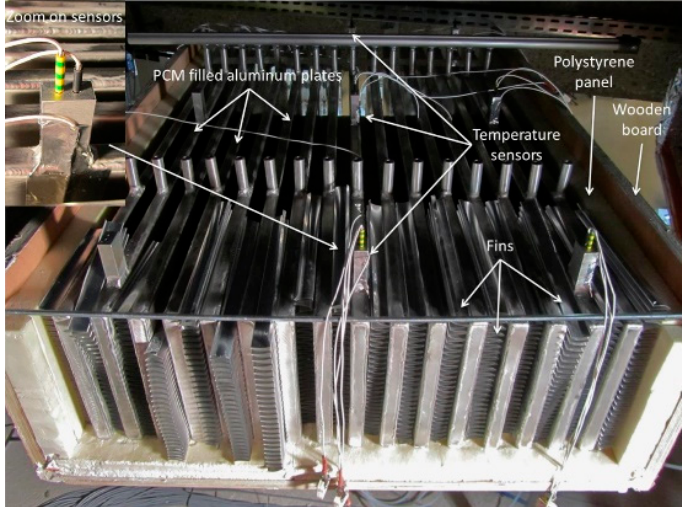
Figure 8. PCM storage unit used for peak load shifting in Stathopoulos et al. study [101].